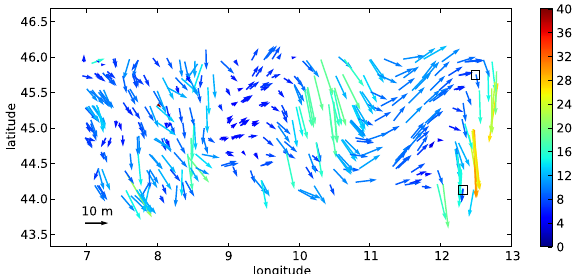
Figure 8: Evaluation of the bundle block adjustment with DEM and GCPs in the upper and lower right corners (indicated by the black boxes).